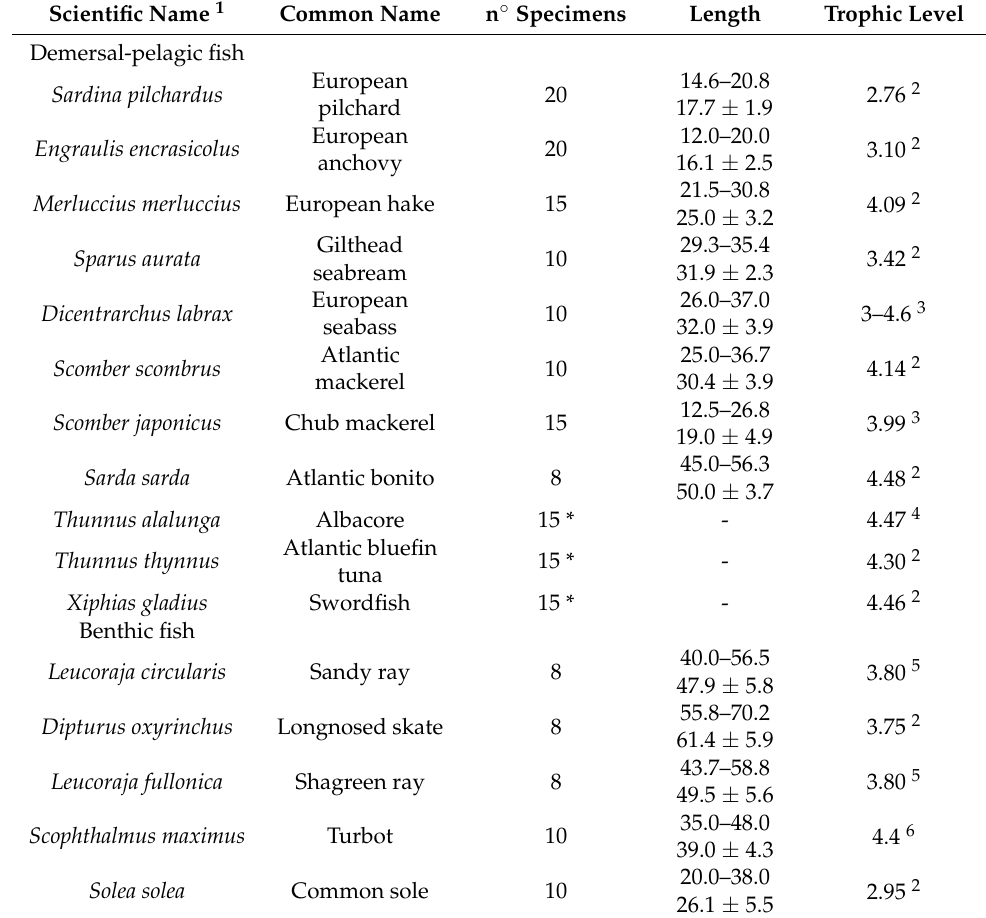
Table 1. Nomenclature, total length (min-max and mean ± SD) and trophic levels of the studied